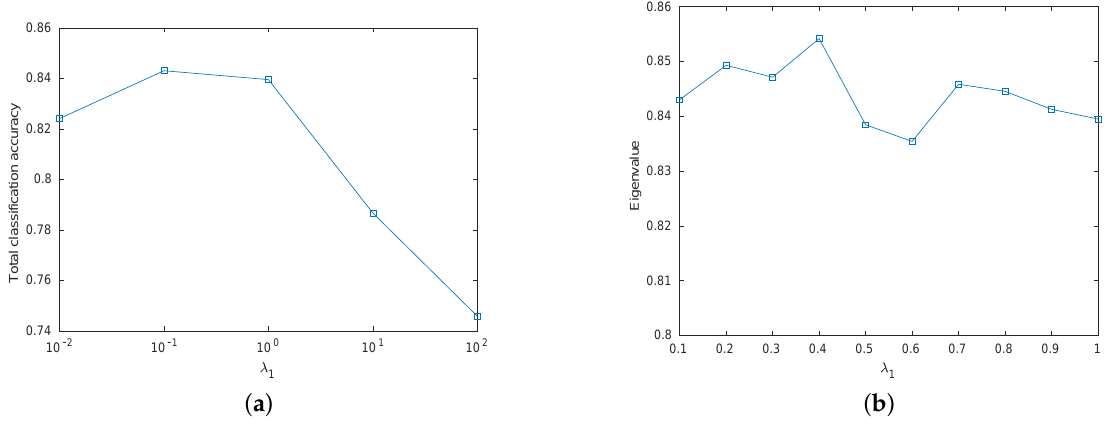
Figure 10. Eigenvalue versus varying scale parameter λ 1 . ( a ) λ 1 varies from 0.01 to 100. ( b ) λ 1 varies from 0.1 to